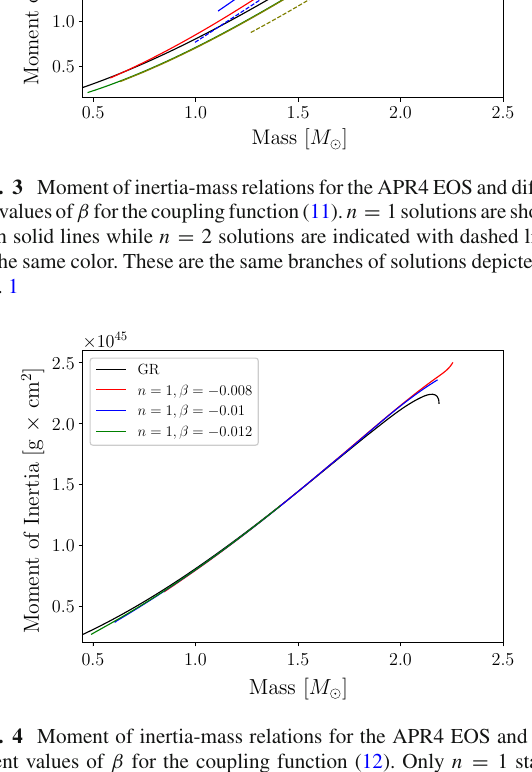
Fig. 4 Moment of inertia-mass relations for the APR4 EOS and dif- ferent values of β for the coupling function (12). Only n = 1 stable solutions exist for this coupling function. These are the same branches of solutions depicted in Fig.